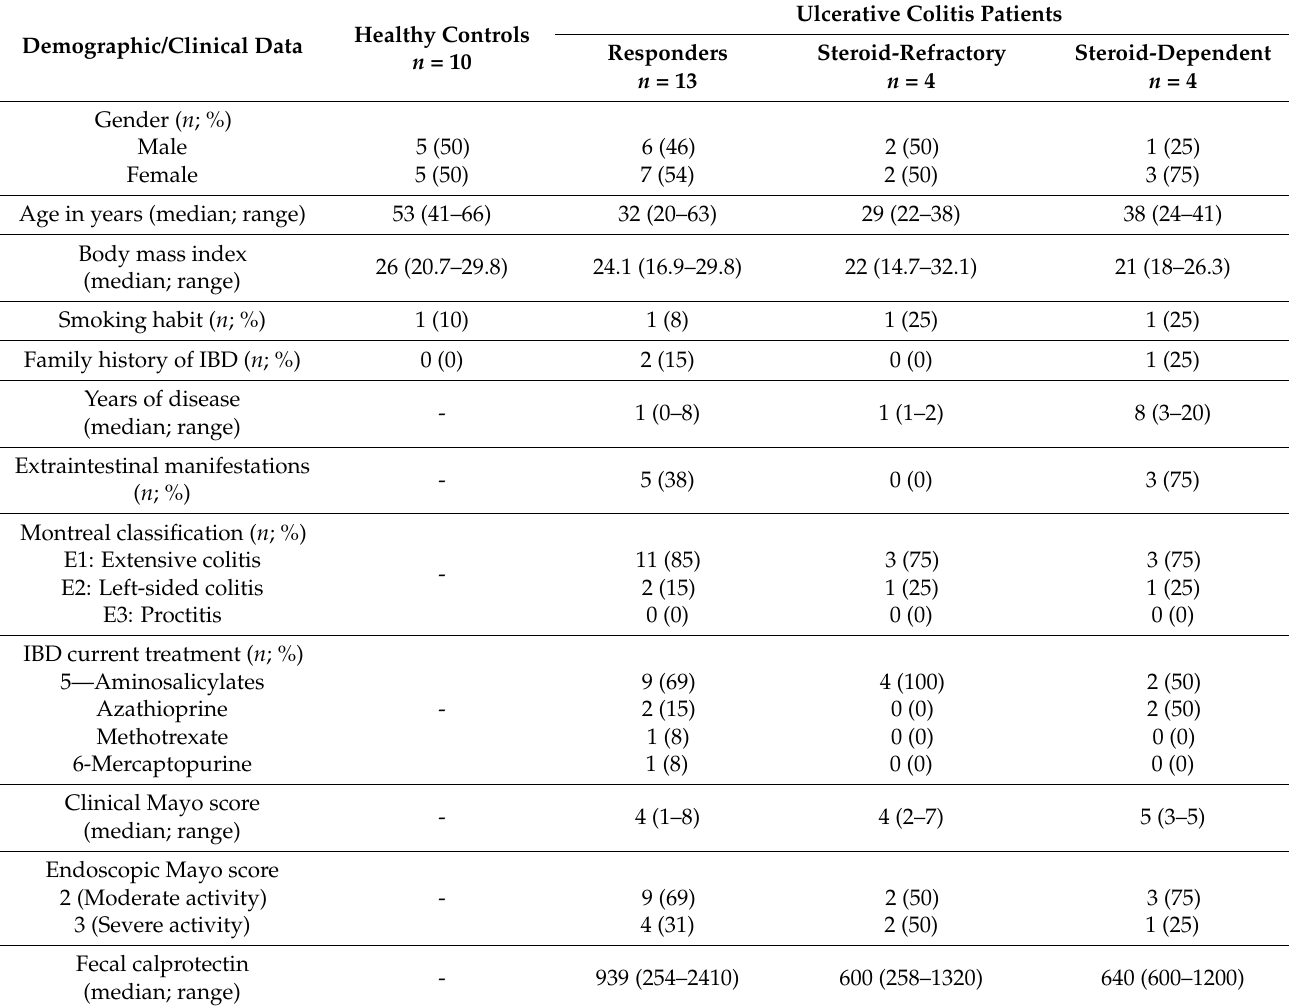
Table 1. Clinical and demographic characteristics of enrolled